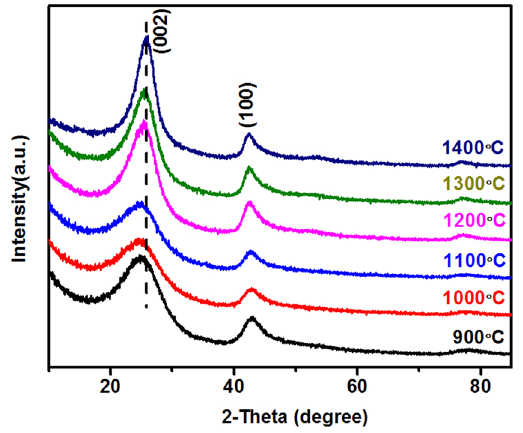
Figure 1. XRD patterns of porous BN microfibers prepared at different calcination